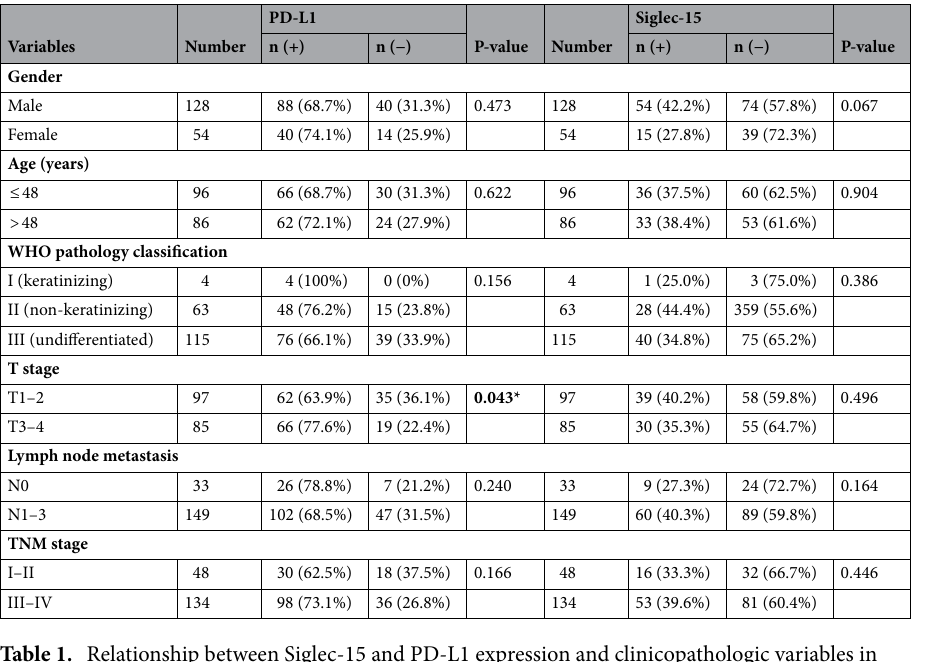
Table 1. Relationship between Siglec-15 and PD-L1 expression and clinicopathologic variables in nasopharyngeal carcinoma. Siglec-15 Sialic acid-binding immunoglobulin-like lectin 15; PD-L1 programmed cell death-Ligand 1. The bold value represents p > 0.05, indicating that the difference is statistically significant.